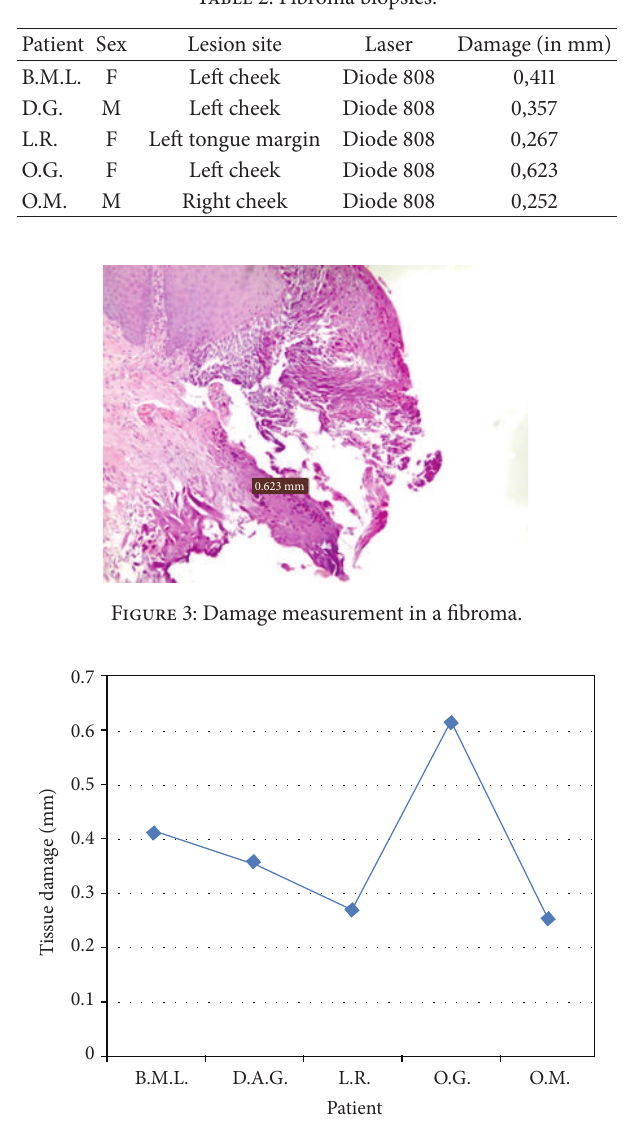
Figure 4: Representation of peri-incisional marginal damage in